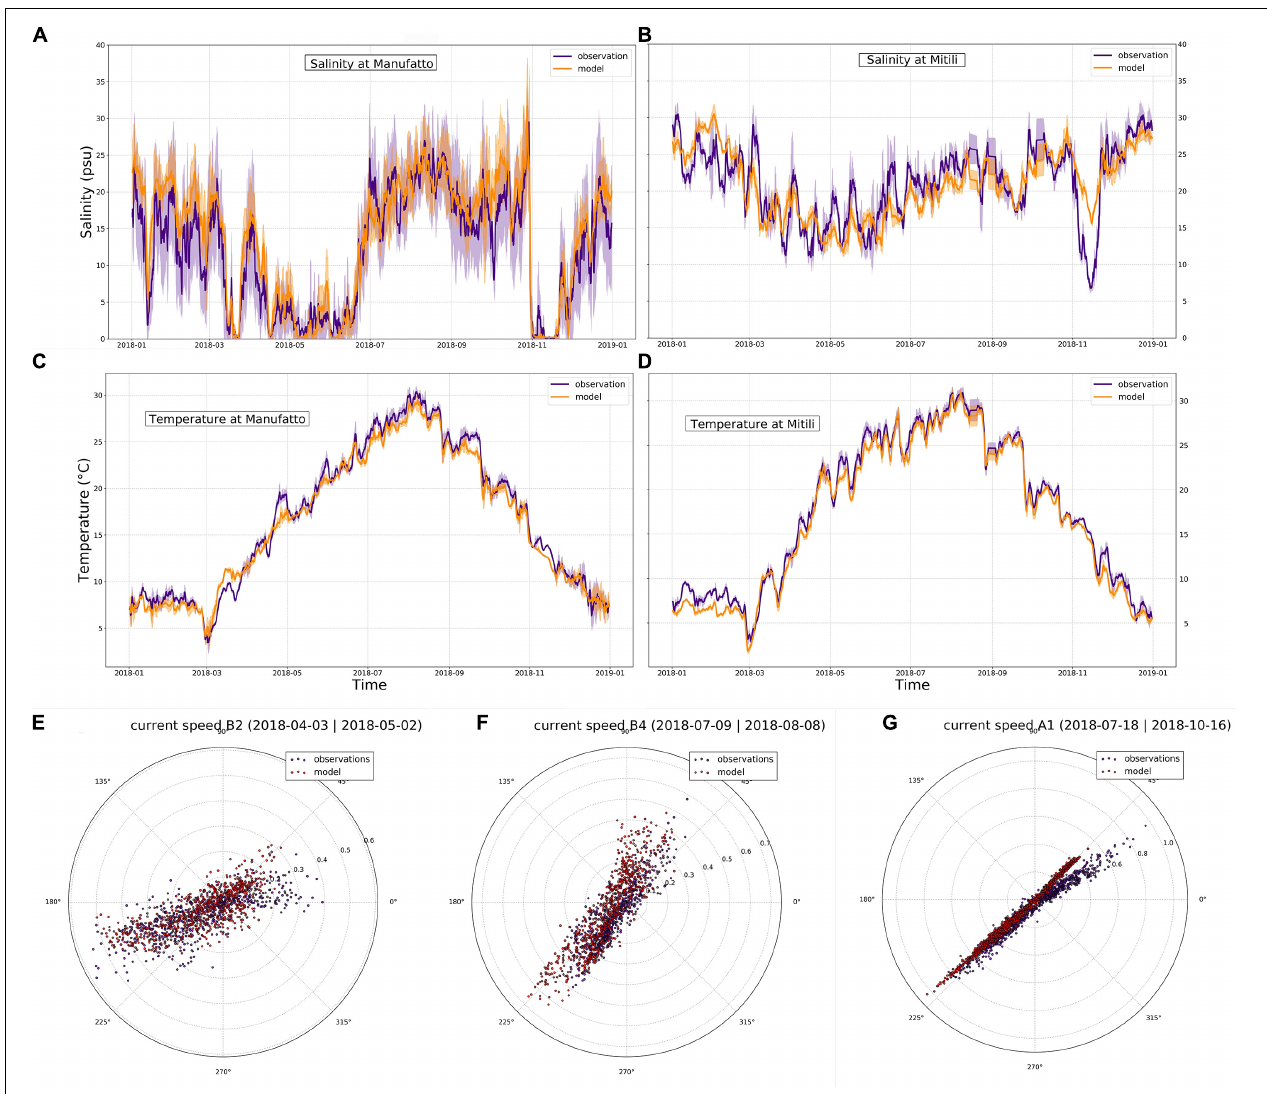
FIGURE 3 | Comparison of observed and calculated salinity and temperature at the Manufatto (MA) (A , C) and Mitili (MI) (B,D) stations. The solid lines and the shaded areas are respectively the 24 h running mean and standard deviation. In panels (E–G) , the comparisons of the polar plots of calculated and observed water velocity in the western inlet channel (B2), in the eastern inlet channel (B4) and Manufatto (MI or A1).